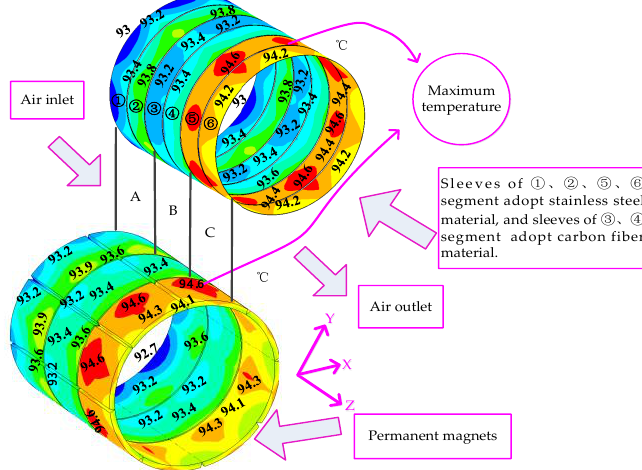
Figure 4. Temperature distribution of permanent magnets and sleeves for the prototype PMSM.